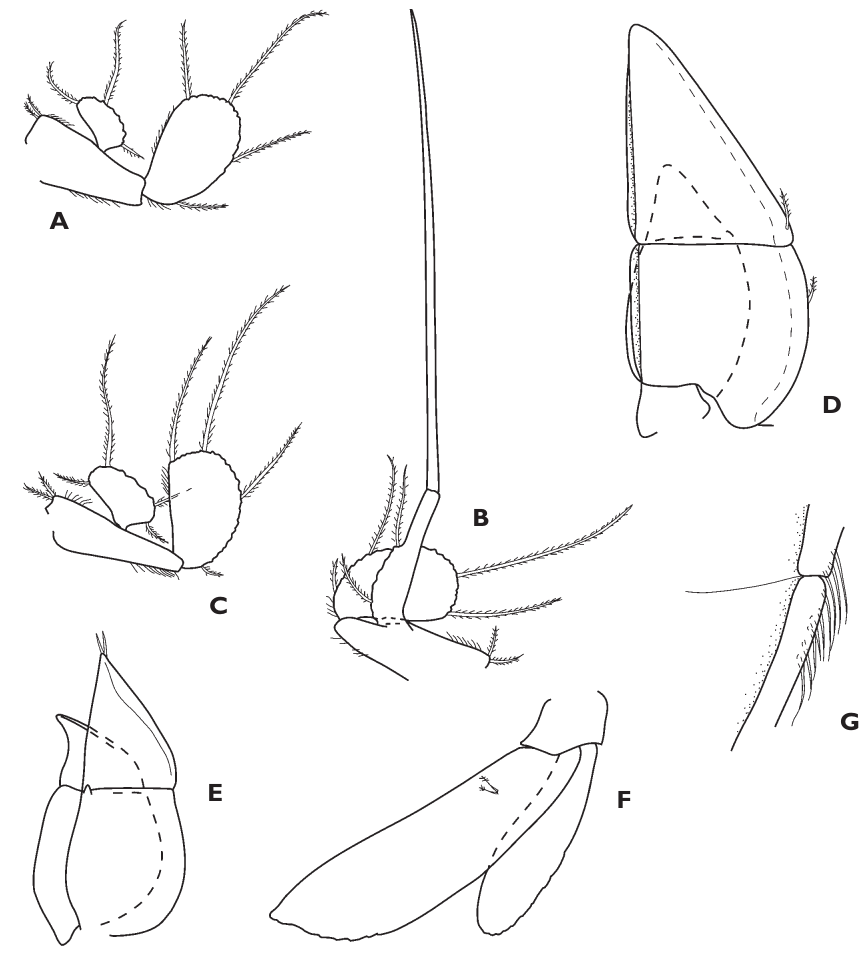
Figure 4. Heteroserolis pellucida sp. n. Paratype ♂ 10.5 mm, Is.6017. A–E pleopods 1–5 respectively F uropods G lateral margin, pleopod 1